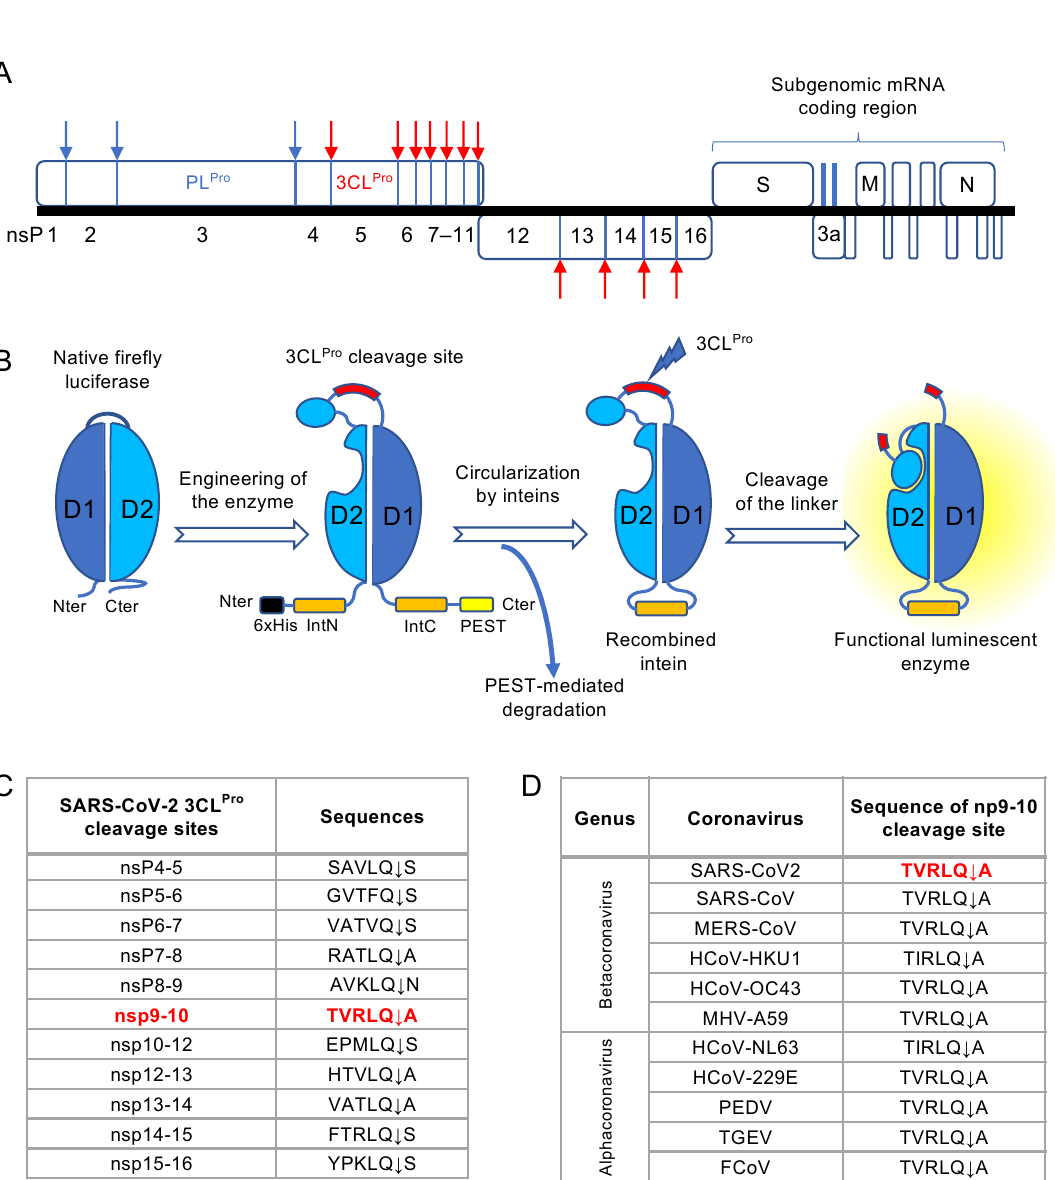
Figure 1. Development of a luminescent biosensor to measure the protease activity of SARS-CoV-2 3CL Pro . ( A ) Schematic representation of SARS-CoV-2 genome with corresponding opened reading frames. PL Pro and 3CL Pro cleavage sites within the non-structural polyprotein are indicated by blue and red arrows, respectively. ( B ) Schematic representation of the luminescent biosensor designed for detecting 3CL Pro activity. Firefly luciferase N and C-terminal fragments 4-233 (D1) and 234-544 (D2) were circularly permuted, and linked together by a peptide containing the 3CL Pro cleavage site. The reporter protein is stabilized by circularization thanks to the IntN and IntC domains, while the PEST sequence promotes the degradation of non-ligated proteins. Upon proteolytic cleavage, constrained domains are relaxed and fold into a functional luminescent enzyme. ( C ) List of 3CL Pro cleavage sites that are present in SARS-CoV-2 polyprotein ORF1ab. The nsp9-10 junction that was used in the luminescent biosensor is colored in red. ( D ) Sequence of the nsP9-10 junction across different alpha and betacoronaviruses. MHV is for Murine Hepatitis Virus or murine coronavirus, PEDV is Porcine Epidemic Diarrhea Virus, TGEV is for Transmissible Gastroenteritis Coronavirus and FCoV is for feline coronavirus.